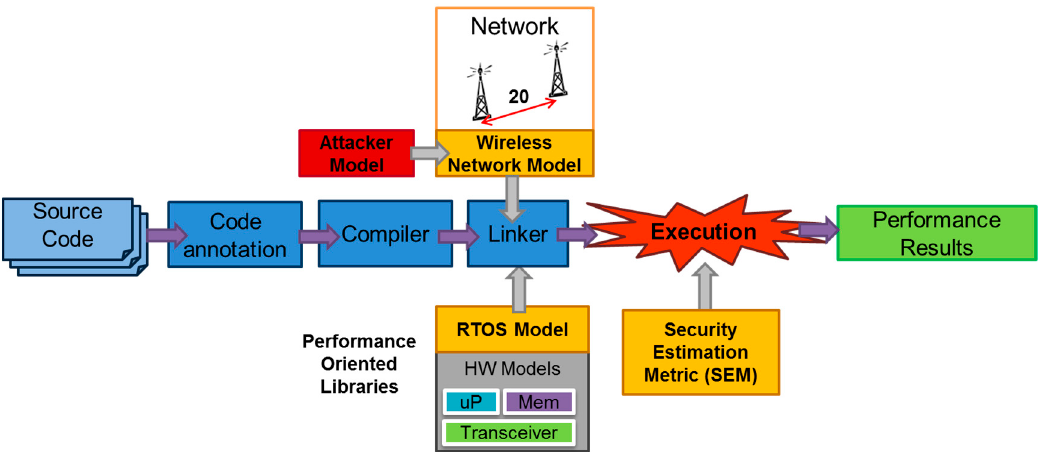
Figure 3. Native/Host-compiled co-Simulation process in the WSN virtual platform.